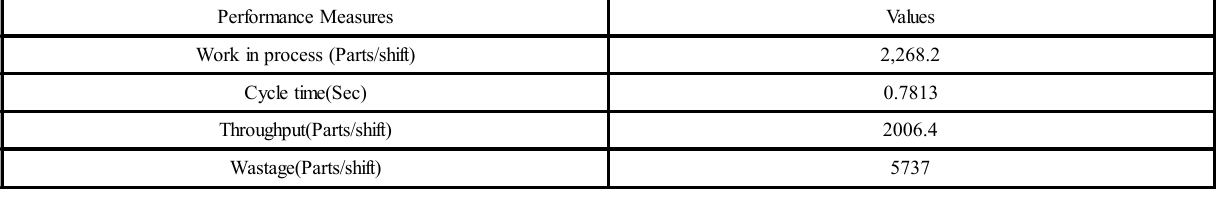
TABLE 8. PERFORMANCE MEASURES (SIMIO